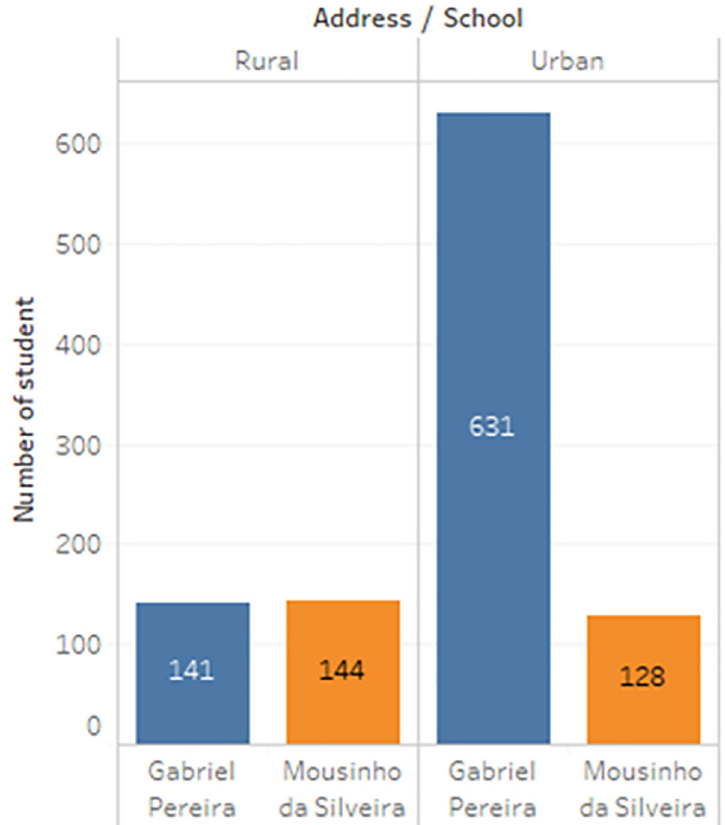
Figure 5. Distribution of student